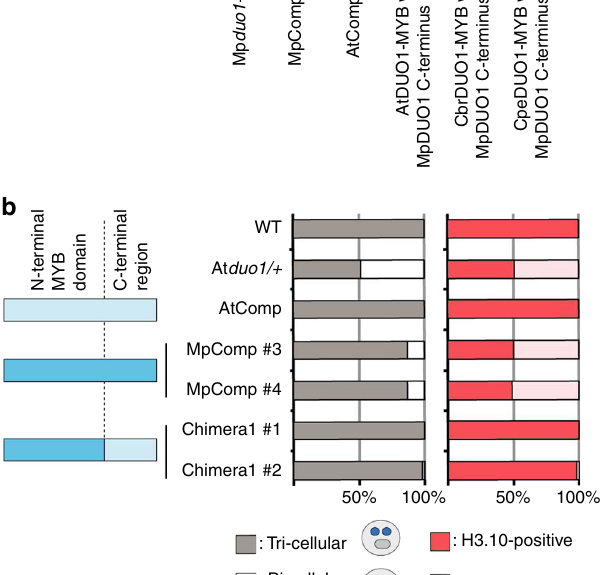
Fig. 3 Functional conservation of DUO1 MYB domains. a Motility of mature sperm cells of WT and Mp duo1-1 ko complemented with the Mp DUO1 genomic fragment (MpComp #5), pro Mp DUO1: At DUO1 (AtComp #9), pro Mp DUO1:AtChimera (AtDUO1-MYB with MpDUO1 C-terminus #13), pro Mp DUO1 : CbrChimera (CbrDUO1-MYB with MpDUO1 C-terminus #1), and pro Mp DUO1 : CpeChimera (CpeDUO1-MYB with MpDUO1 C-terminus #1). Percentage of motile sperm (upper) and average velocity (lower) of motile sperm based on analysis of three movies for each line are shown. N. A., not applicable, because spermatids abort in Mp duo1-1 ko and Mp duo1-1 ko complemented with pro Mp DUO1 : CpeChimera (see Fig. 2b and Supplementary Figure 3e). The numbers of sperm observed are: n = 25, 23, 155 (WT), n = 46, 51, 58 (MpComp #5), n = 27, 32, 25 (AtComp #9), n = 7, 80, 94 (AtChimera #13), n = 44, 50, 59 (CbrChimera #1) for analysis of fraction of motile sperm; n = 117 (WT), n = 67 (MpComp #5), n = 10 (AtComp #9), n = 8 (AtChimera #13), n = 12 (CbrChimera #1) for analysis of swimming velocity. b Genetic complementation of At duo1 by At DUO1 , Mp DUO1 , a chimera of the DNA-binding domain of Mp DUO1 with the activation domain of At DUO1 . The degree of complementation is measured by rescue of pollen phenotype (left) and expression of H3.10 encoded by HTR10 (right). Schematic diagram of the constructs used for complementation are shown on the far left. Construct parts are color-coded light blue (AtDUO1) and dark blue (MpDUO1) (see Fig. 4b for details). n